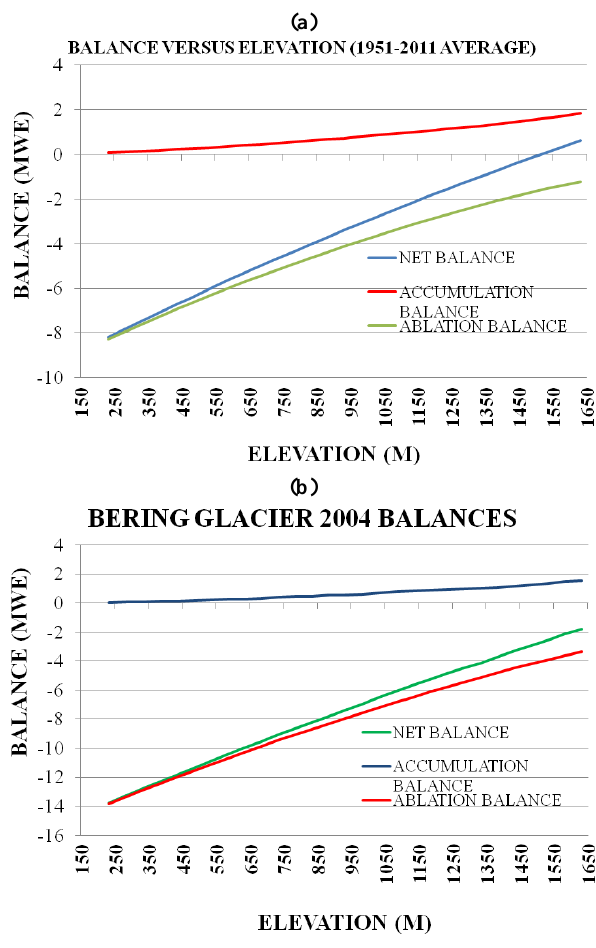
Fig. 9. Daily balances of Bering Glacier during the 2011 bal- Figure 9. Daily balances of Bering Glacier during the 2011 balance 380 ance year. The final net balance for 2011 on 30 September equals year. The final net balance for 2011 on September 30 equals -1.7 mwe, 381 − 1.7mw.e., the accumulation balance is 1.0 and the ablation bal- the Accumulation Balance is 1.0 and the Ablation balance is -2.7 mwe. 382 ance is − 2.7mw.e. Snow accumulation on Bering Glacier begins Snow accumulation on Bering Glacier begins on approximately August 383 on approximately 1 August each year, thus “winter” balance is a 1 each year, thus “winter” balance is a misnomer for this glacier. 384 misnomer for this glacier. 387 Englacial (liquid) water storage in a temperate glacier is calculated by 388 input and output observations of precipitation and runoff (Tangborn, et al, 389 1972) and is considered a critical factor in glacier surges (Kamb, 1987, 390 Merrand and Hallet, 1996, Fatland and Lingle, 1998). During the 1993-95 391 surge of Bering Glacier, downward movement of englacially stored water 392 produced a failure of subglacial till causing rapid basal sliding (Lingle and 393 Hallet,